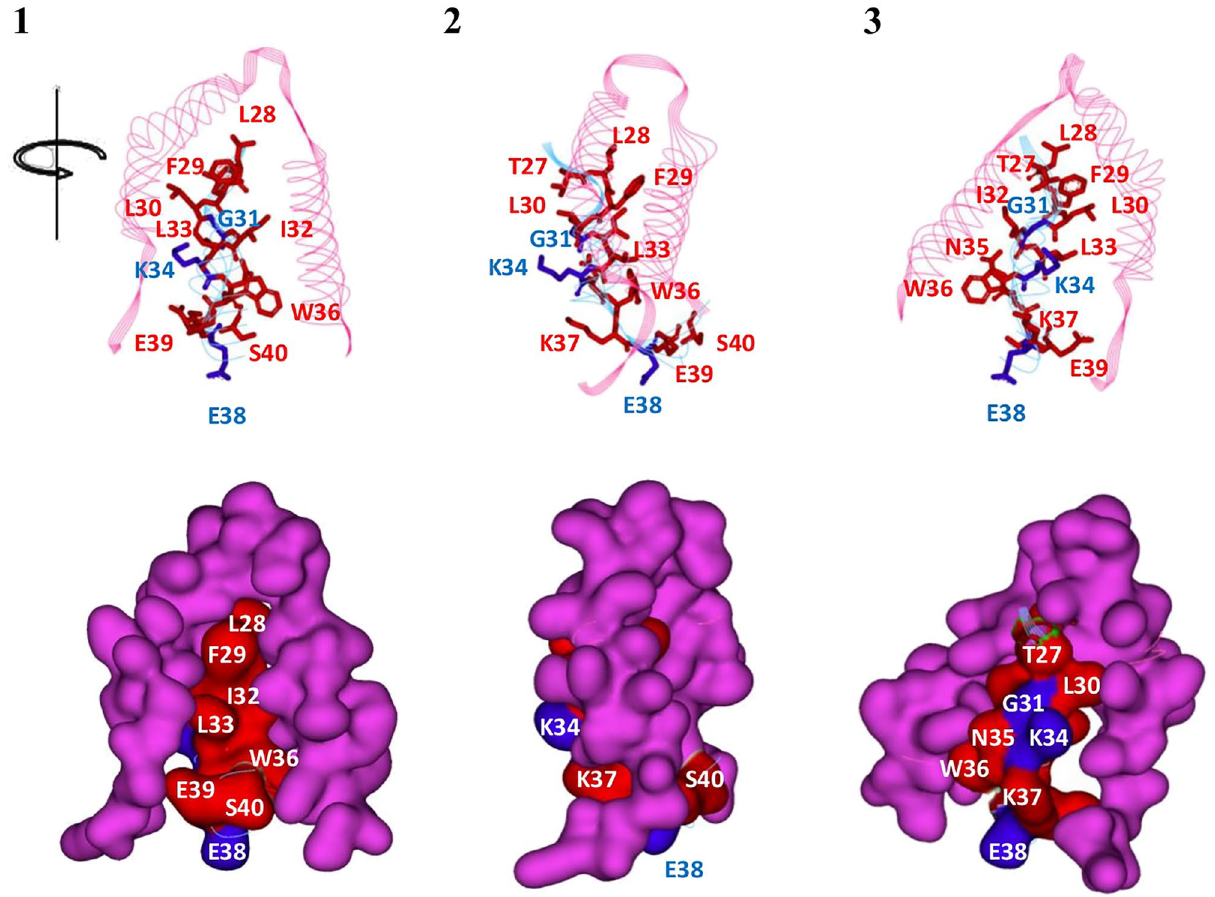
Figure 3. Rotation view of intermolecular neighbors of 27 TLFLGILKNWKEES 40 in human IFN-γ. The interactive (red) and non-interactive (blue) residues on IFN-γ chain A (sky) with respect to IFN-γ chain B (pink) were classified by the bond length between two chains being ≤ 5 and 5 Å,